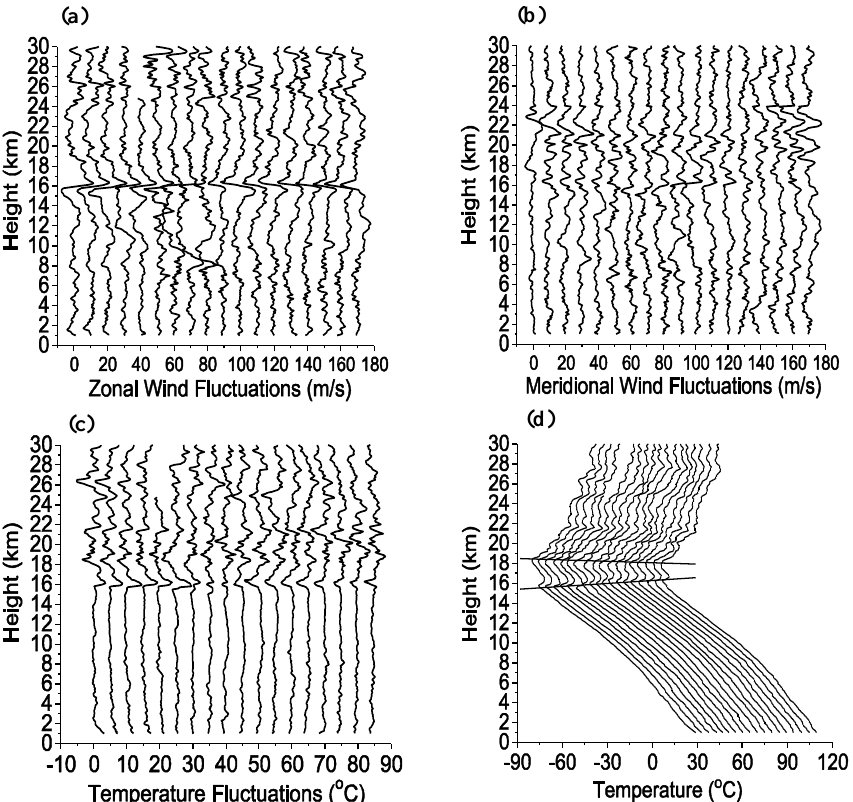
Figure 7. Fluctuation in (a) zonal (upper panel left), (b) meridional wind (upper panel right), (c) temperature profiles (lower panel left), and (d) original temperature profiles (lower panel right)on 9 December 2005. Profiles are shown every hour starting at 13:00LST to 07:00LST (next day). These are shifted rightward by adding a constant (10 in upper panels and 5 in lower panels) to avoid overlapping. Two horizontal lines are drawn around 16km and 18km heights to denote the two tropopause height levels, which merges with time. Line drawn in meridional wind near 22km shows a short vertical wavelength but long period waves (diurnal/semi diurnal).